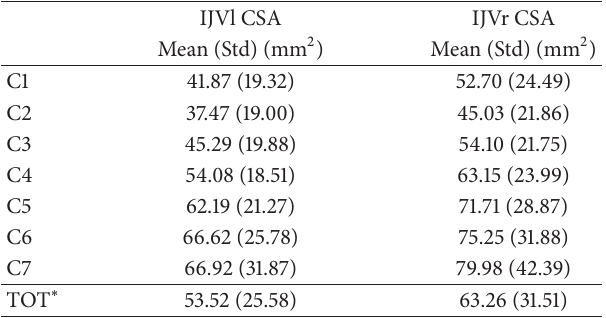
Table 1: Group average and standard deviation of IJVl and IJVr CSAs for all cervical levels between C1 and C7 considered separately and aggregated (TOT).